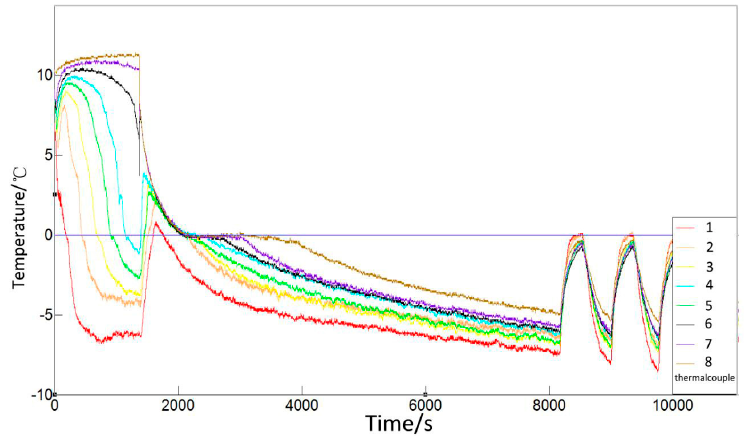
Figure 8. Temperature variation of the evaporating tube wall during the operation period.